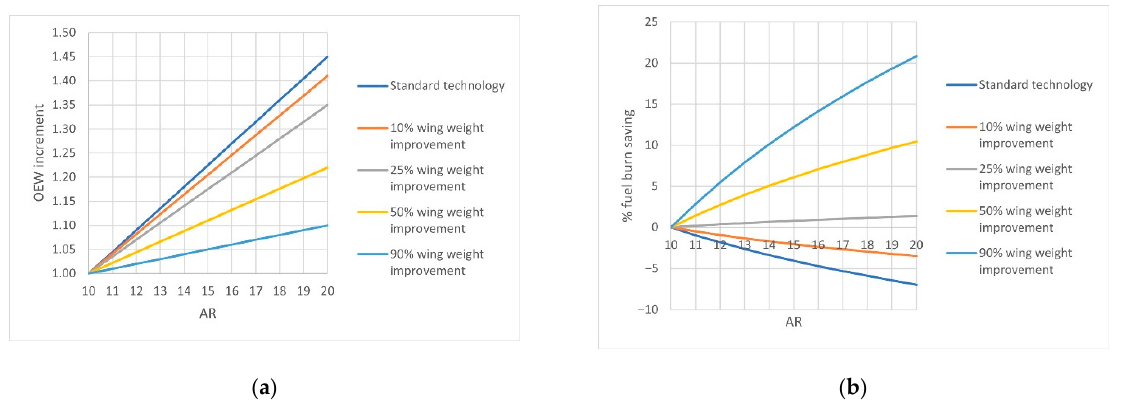
Figure 30. Example of potential weight increase and fuel burn variation due to aspect ratio variation: ( a ) change in operative empty weight; ( b ) change in fuel burn.